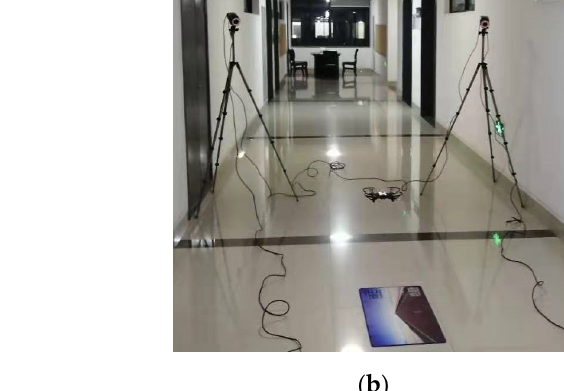
Figure 9. Quadrotor experimental environment. ( a ) Experimental equipment and control loop and ( b ) experimental field.